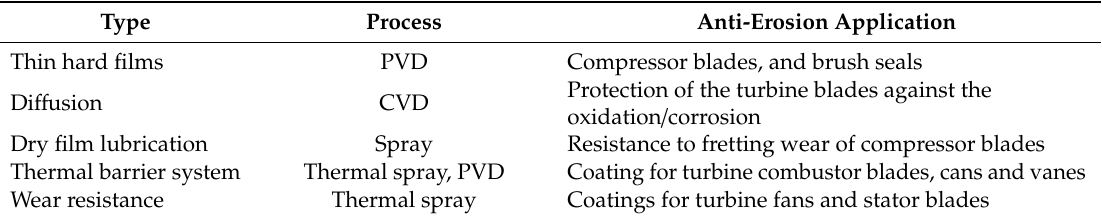
Table 6. Typical coatings applications in GTE [151–153].